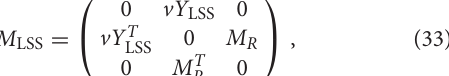
/ BR Full BR V eff =